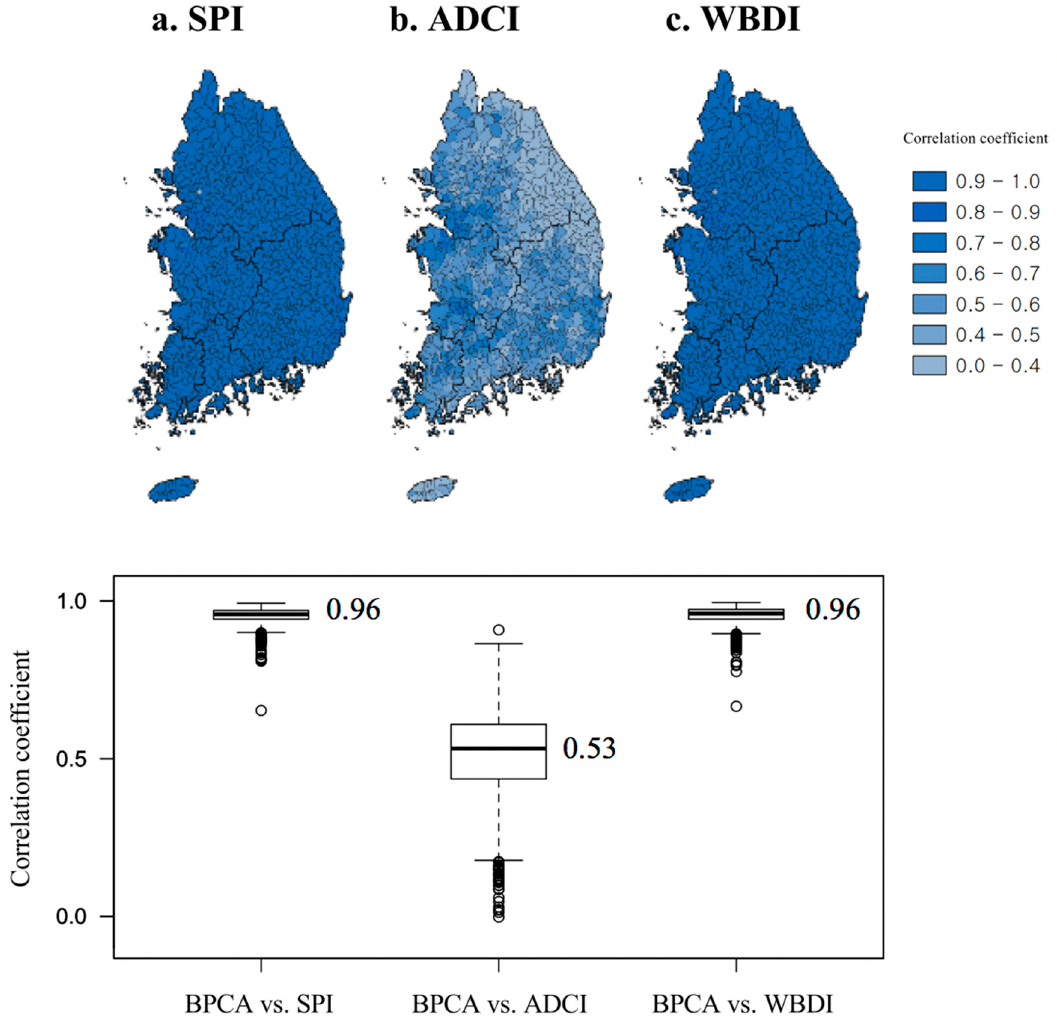
Figure 3. Results of correlation analysis with RS-based integrated drought index (RSIDI) through Bayesian PCA (BPCA); ( a ) SPI (standardized precipitation index), ( b ) ADCI (agricultural dry condition index), and ( c ) WBDI (water budget-based drought index). The lower panel in the figure results from the analysis of the correlation of 849 sub-basins summarized in the boxplot and is illustrated by each applied drought index namely, SPI, ADCI, and WBDI.